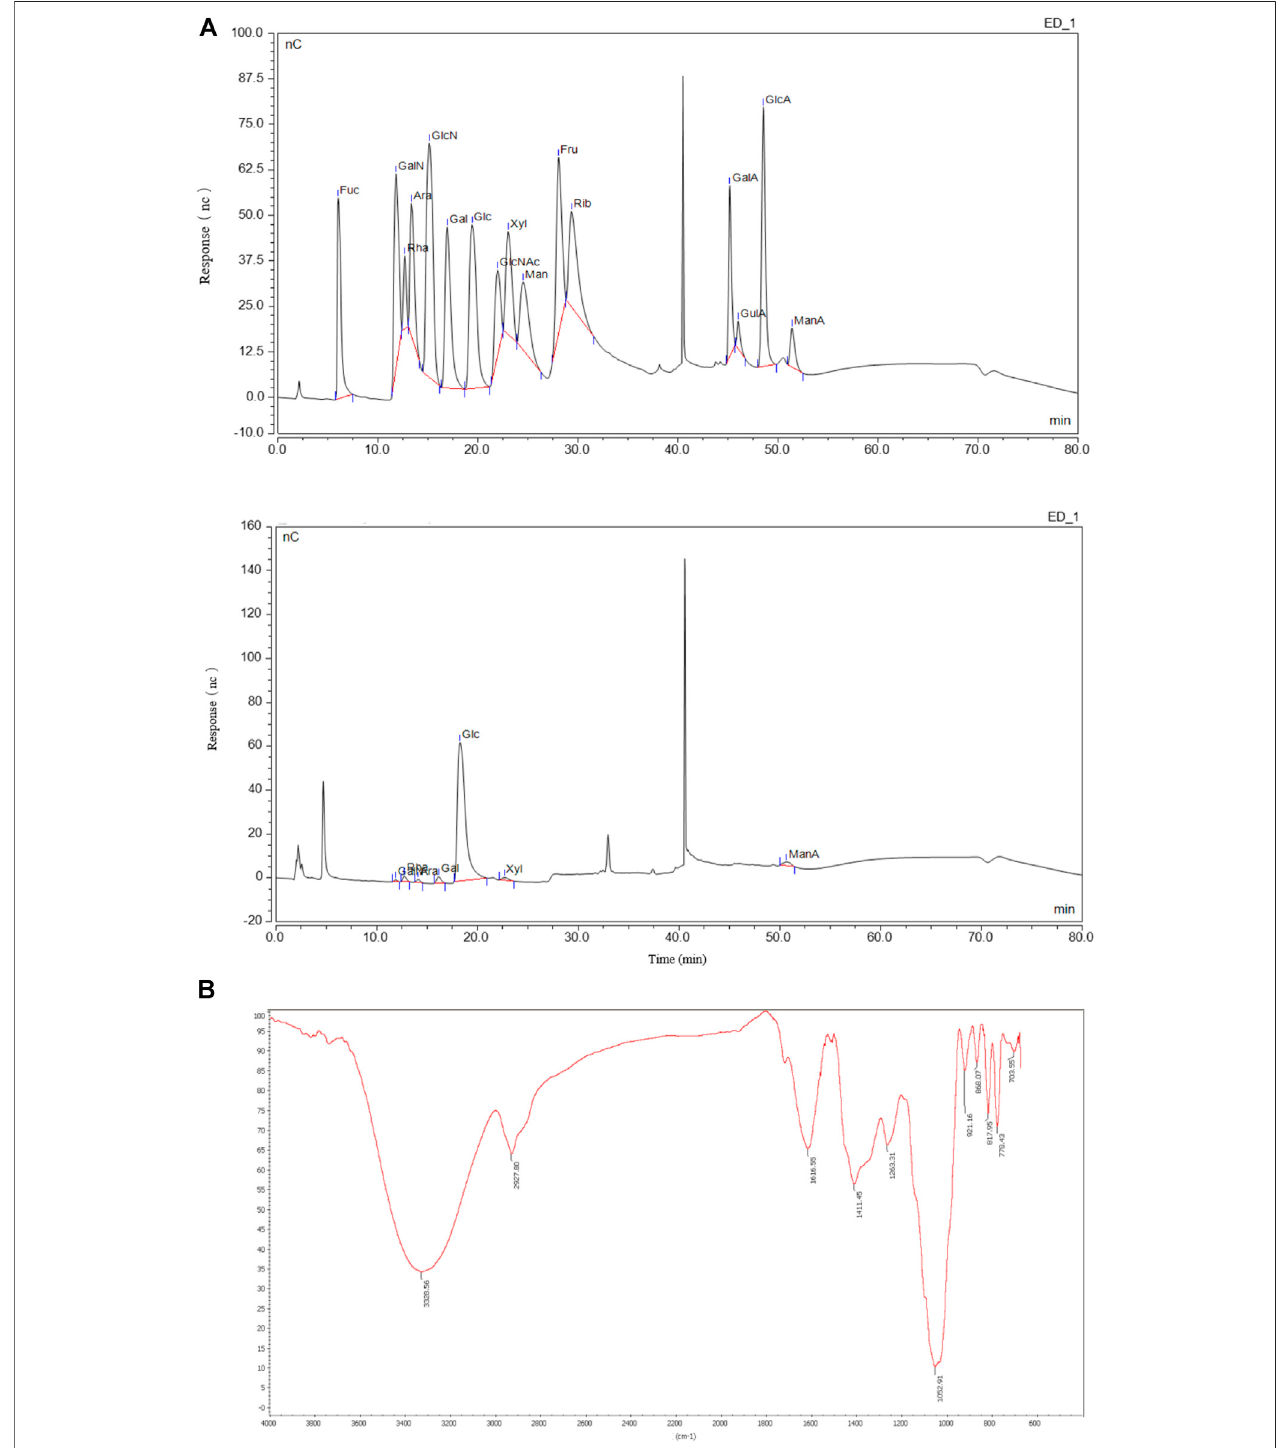
FIGURE1| Monosaccharide compositionsand structure ofQGS. (A) Themonosaccharide standard(upperpanel) andQGSsample(lowerpanel)weremeasured with HPIEC. (B) The structure of QGS was determined by fourier transform infrared spectroscopy.